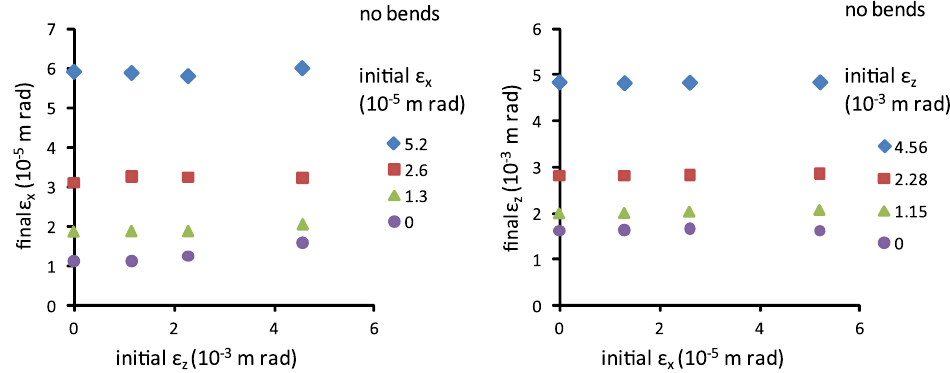
FIG. 7. Final emittance ( x and z ) vs initial emittance ( x and z ), runs with bends removed.